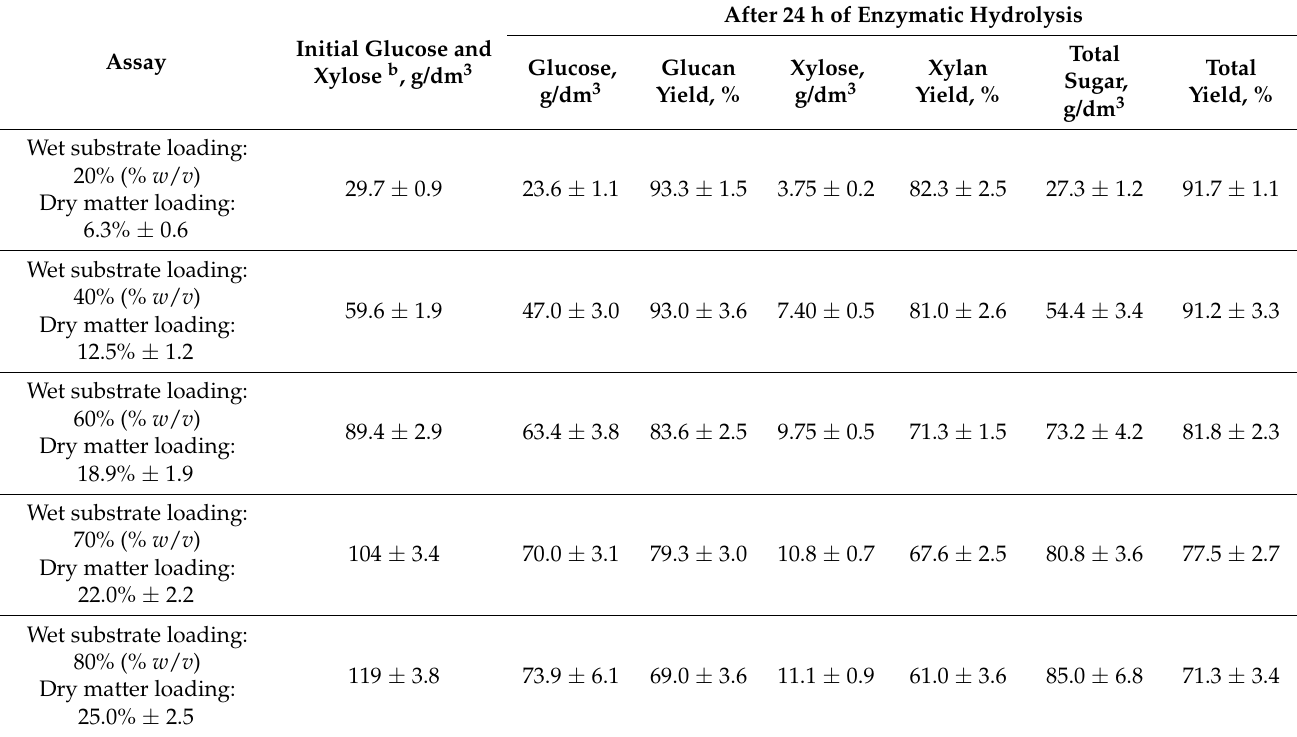
Table 2. Results of enzymatic hydrolysis carried out with selected cocktails mixture (average values n = 3, ± standard deviation) a